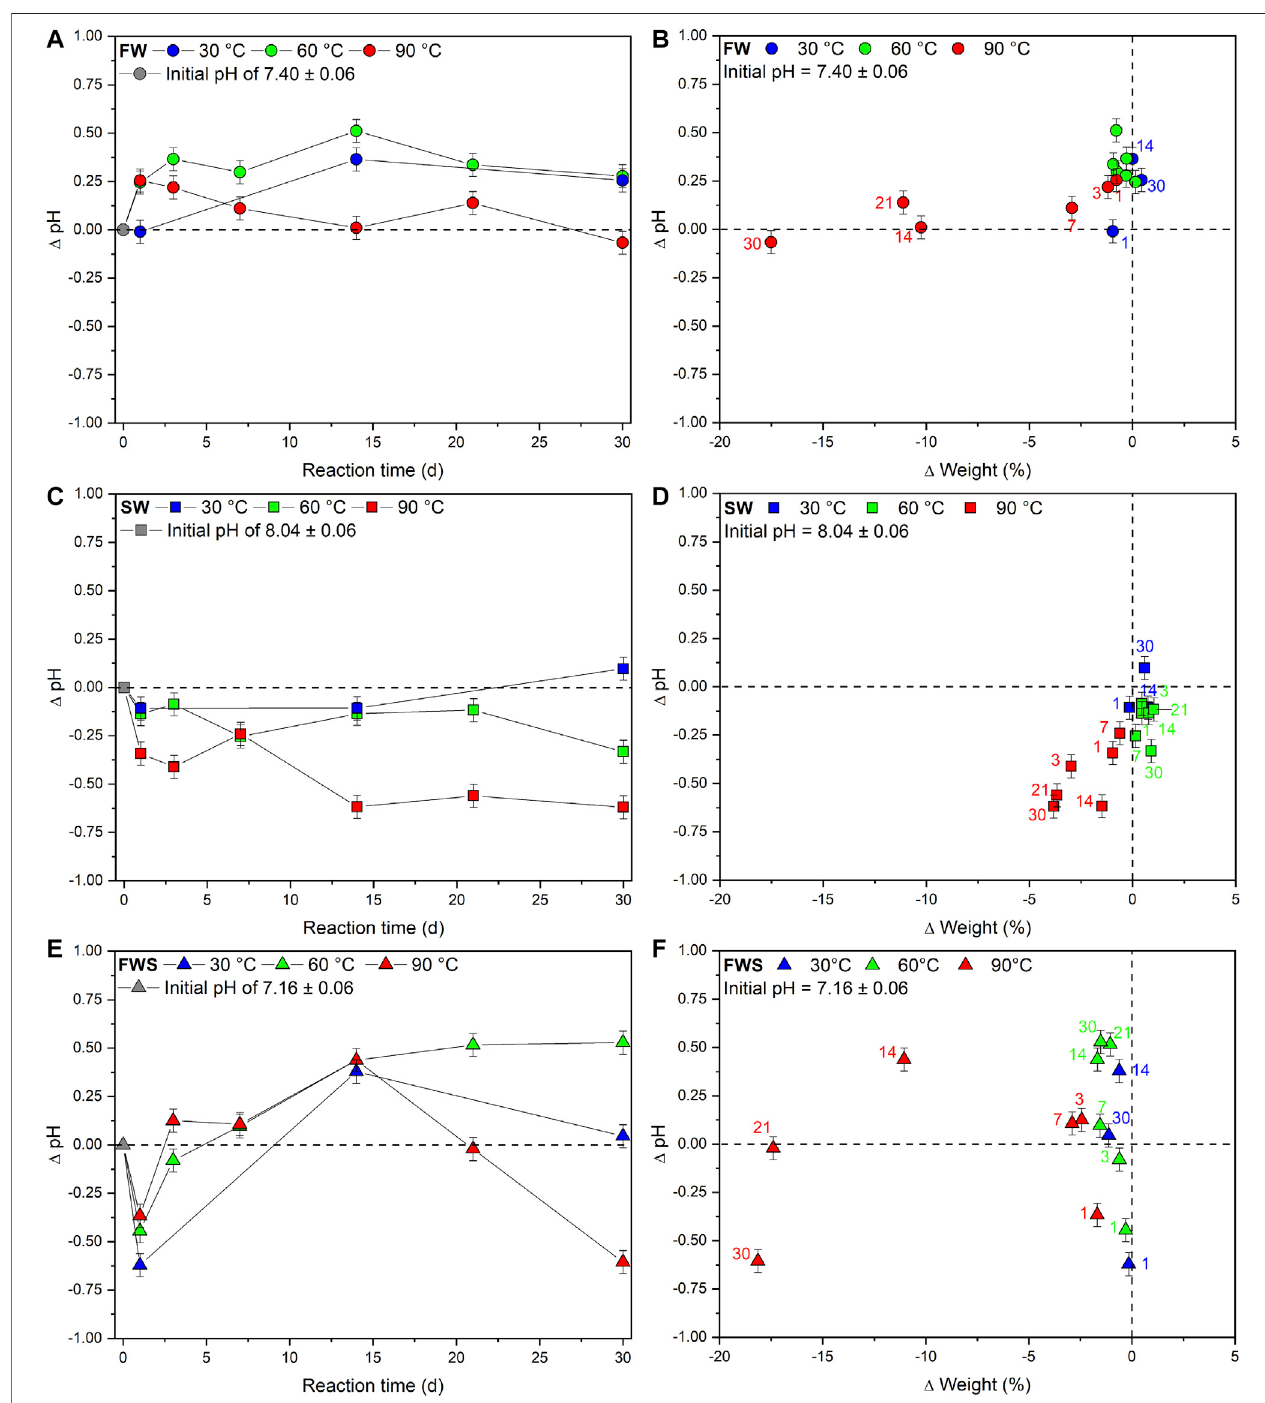
FIGURE 4 | Changes in basic experimental parameters observed during the experiments. (A, C, E) Changes in pH over time as absolute difference from the initial pH oftherespectiveexperimental solution. (B,D, F) Changesin pHrelativetothe changein weight.Colored numbers denote therespectivereaction times indays.In all cases the x error bars are smaller than the symbols. The dashed reference lines represent the initial value of each data point.